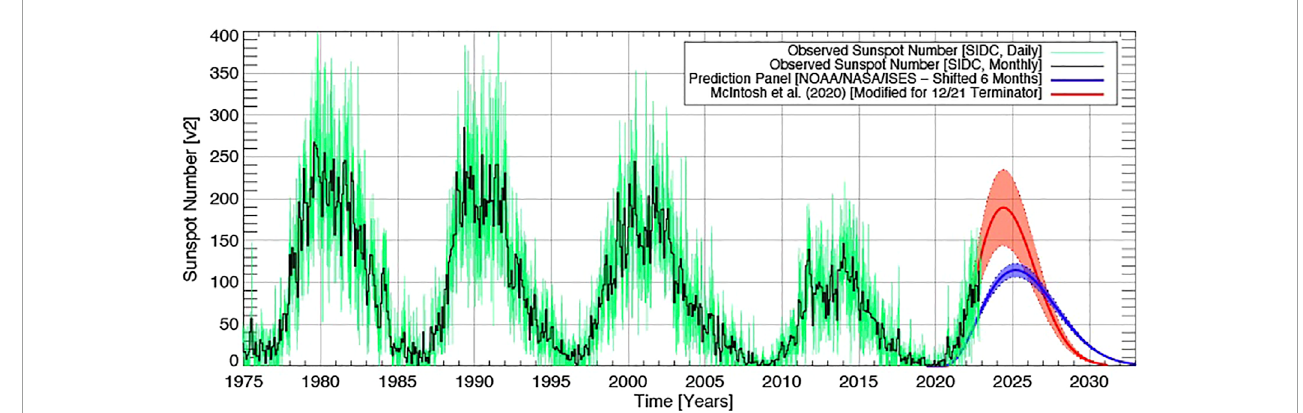
FIGURE 10 Comparing the observed daily (green) and monthly (black) total sunspot number with the updated forecast of SC25 using the factors described in this paper (red) against the community consensus SC25 forecast